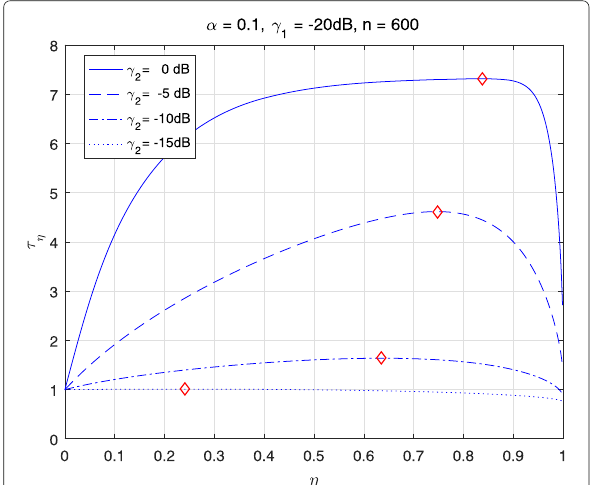
Fig. 6 Detection agility gain versus relay policy under different SNRs of SU